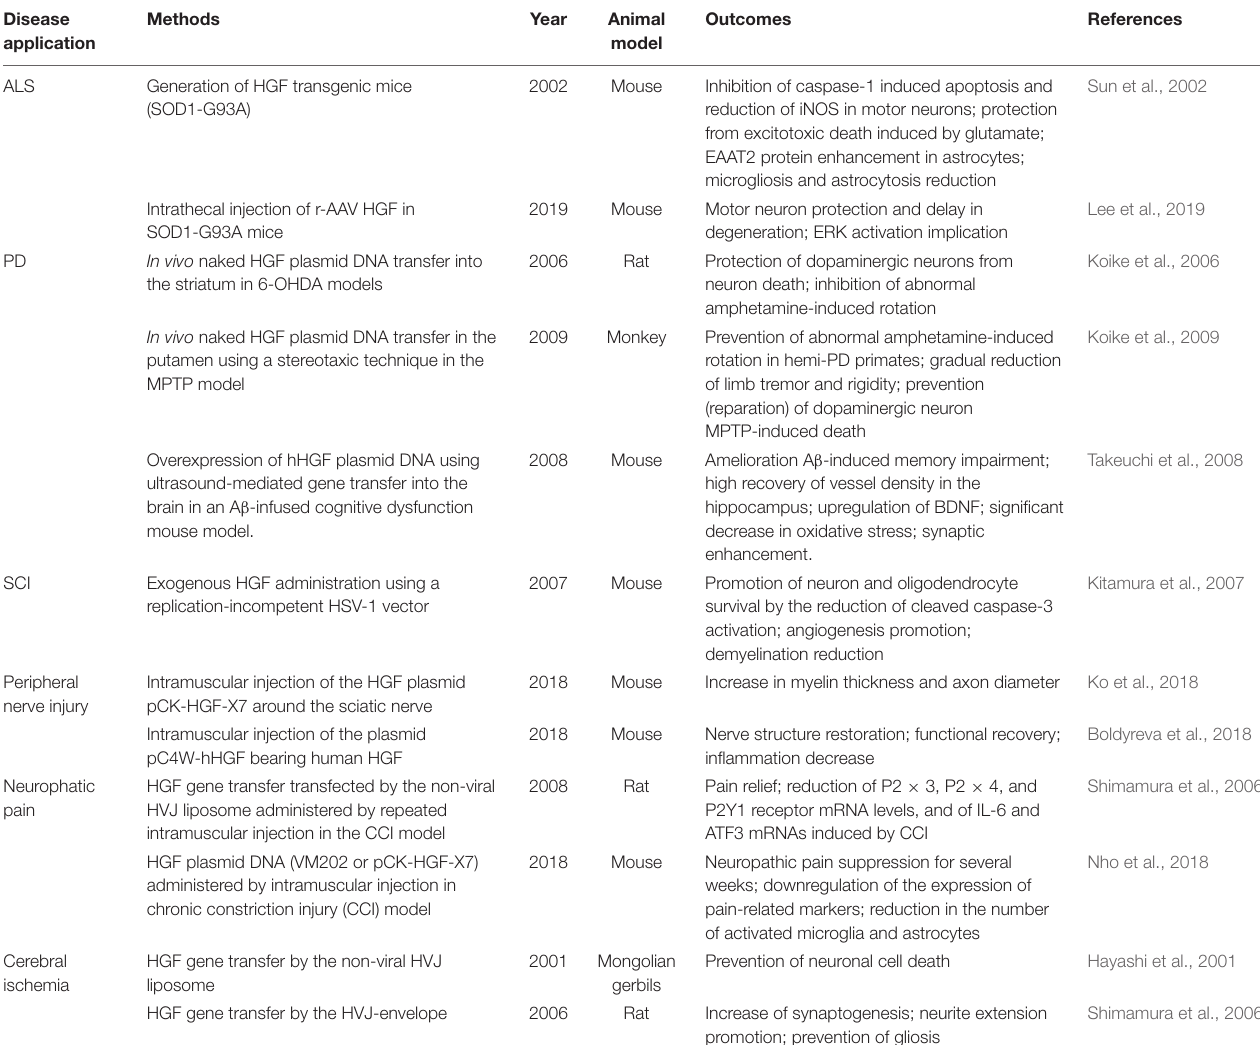
TABLE 2 | Hepatocyte growth factor gene transfer in animal models of neurological diseases. Disease